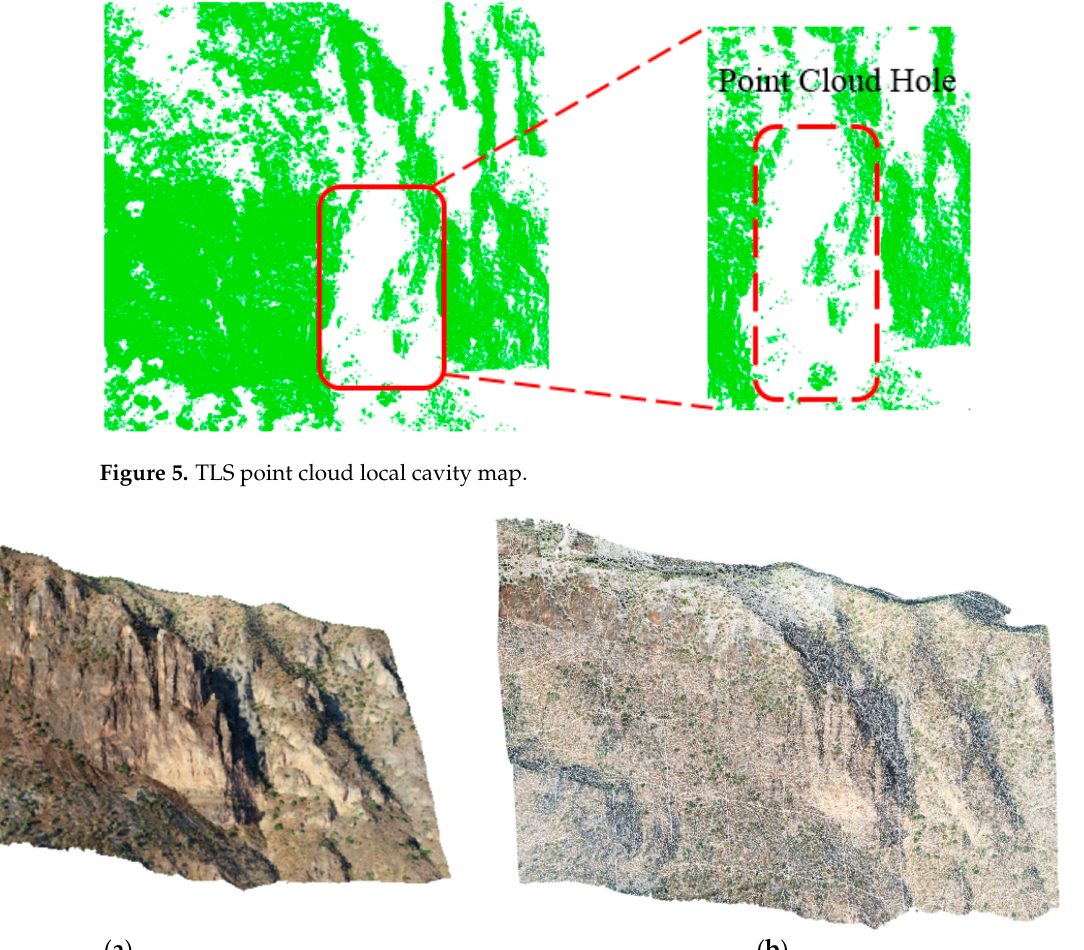
Figure 4. 3D laser data acquisition: ( a ) acquisition of data by ground-based 3D laser scanner; ( b ) scanning area field map; ( c ) scanning point cloud alignment map; ( d ) preprocessing result of point cloud in scanning area.